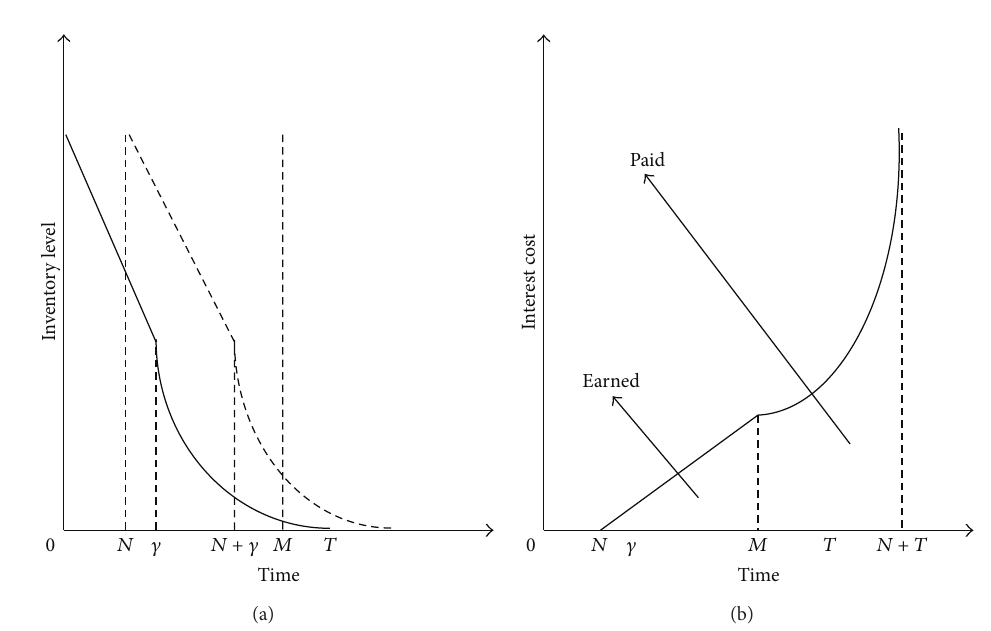
Figure 9: Inventory system for Case 3 when 𝛾 ≤ 𝑇 ≤ 𝑀 − 𝑁 .